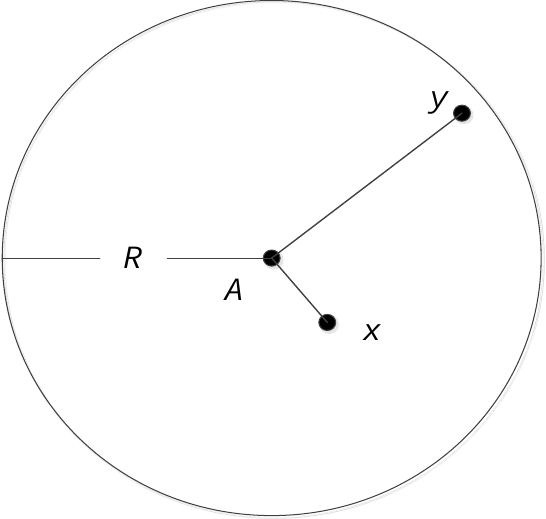
Figure 2. Diagram of hop error.